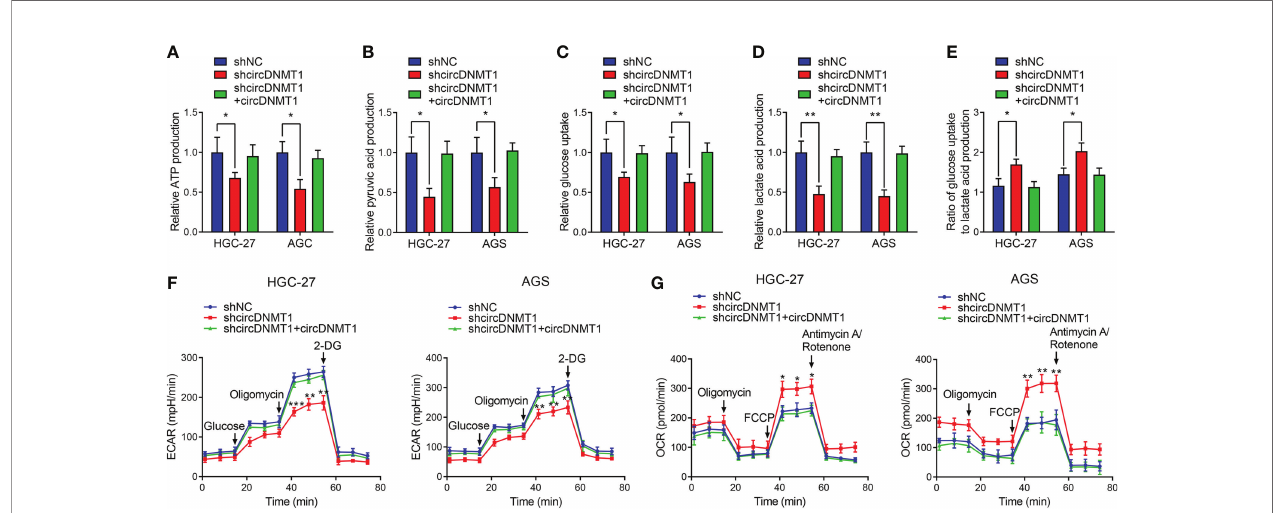
FIGURE 3 | circDNMT1 promotes glycolysis of GC cells. (A – E) ATP production (A) , pyruvic acid production (B) , glucose uptake (C) , lactate acid production (D) and ratio of glucose uptake to lactate acid production (E) were determined in HGC-27 and AGS cells stably carrying lentivirus with NC shRNA or circDNMT1 shRNA and additionally transfected with vector or circDNMT1 overexpression plasmids. (F, G) ECAR (F) and OCR (G) assays of cells as in (A – E) . A series of compounds were added at the indicated time. Data were presented as means ± SD. *P < 0.05, **P < 0.01, ***P < 0.001.